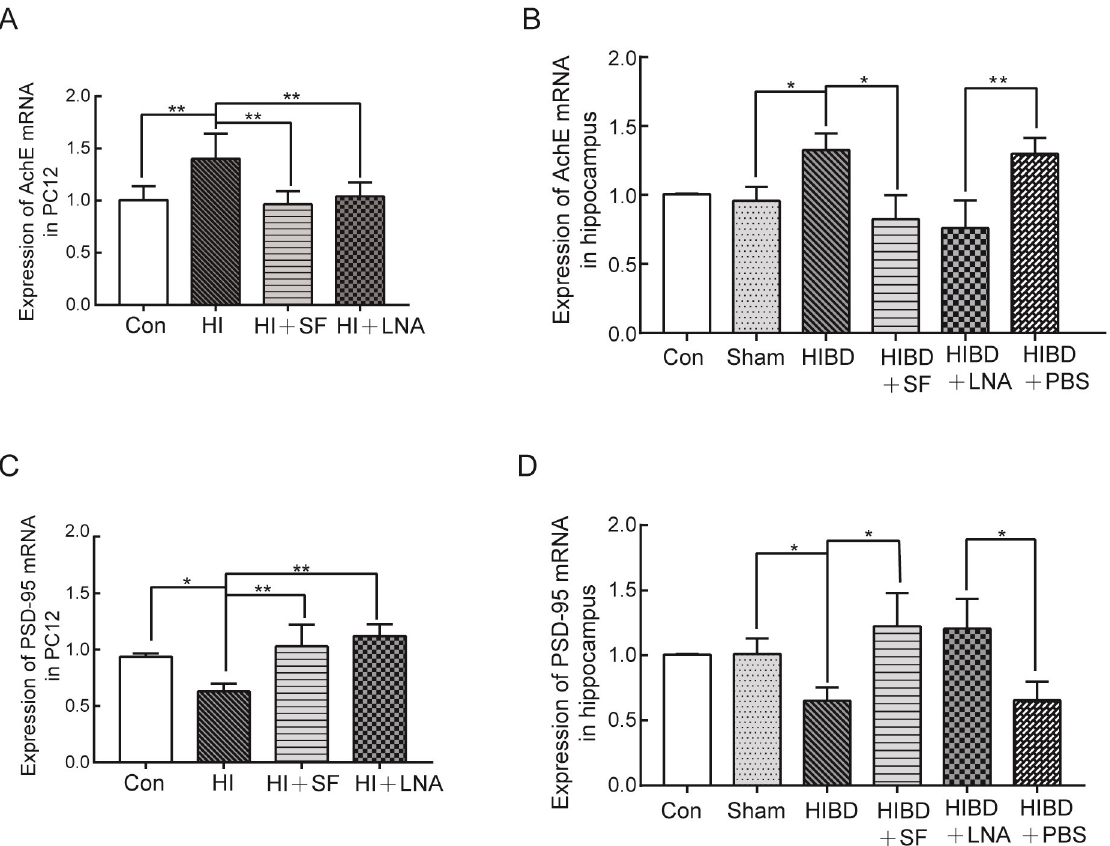
Fig 6. RT-PCR analysis of the gene expression of AchE mRNA and PSD-95 mRNA in PC12 cells and rat hippocampus. SF and LNA effectively reversed the expression changes in AchE mRNA and PSD-95 mRNA caused by hypoxic-ischemic injury. (A) The expression of AchE mRNA in PC12 cells. (B) The expression of AchE mRNA in the rat hippocampus. (C) The expression of PSD-95 mRNA in PC12 cells. (D) The expression of PSD-95 mRNA in the rat hippocampus. �� P < 0.01, � P < 0.05. N = 4 for cell analysis and N = 6 for animal analysis.